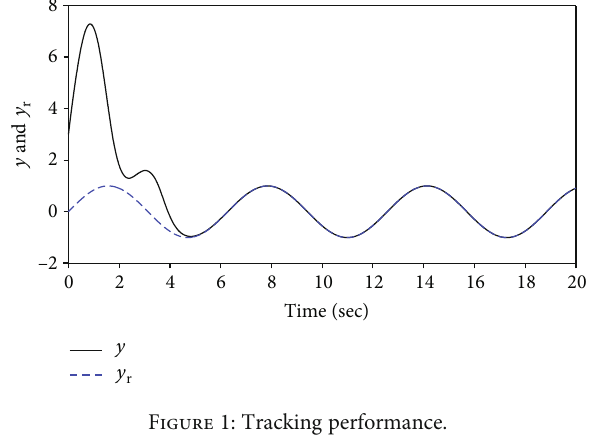
Figure 1: Tracking performance.